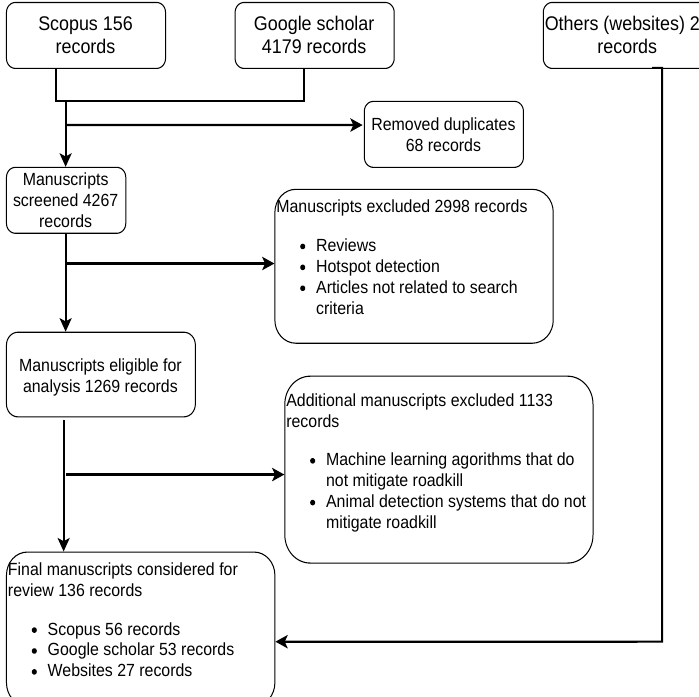
Figure 1. Flow diagram of exclusion and inclusion